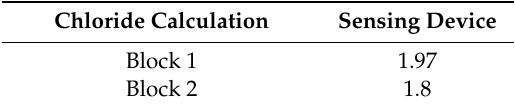
Table 6. Experiment 2 chloride calculation results in M.